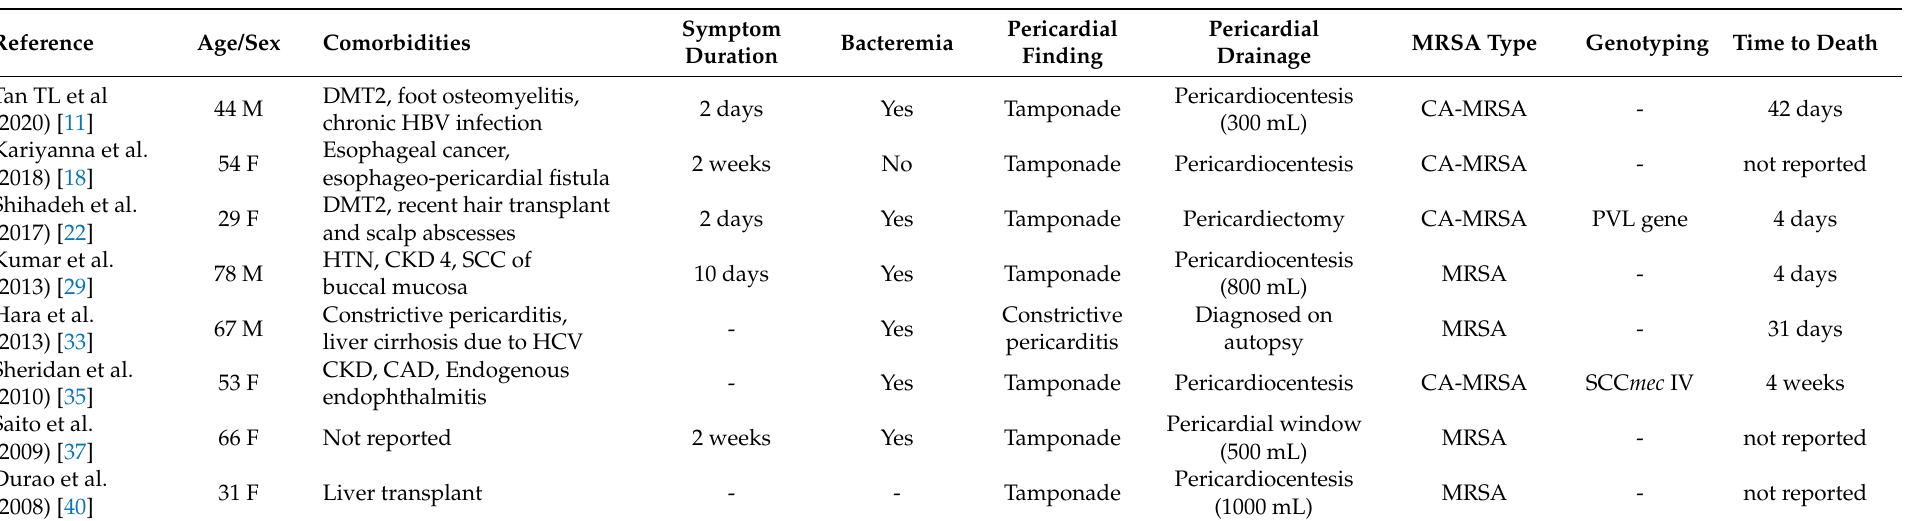
Table 4. Published cases reporting fatal MRSA